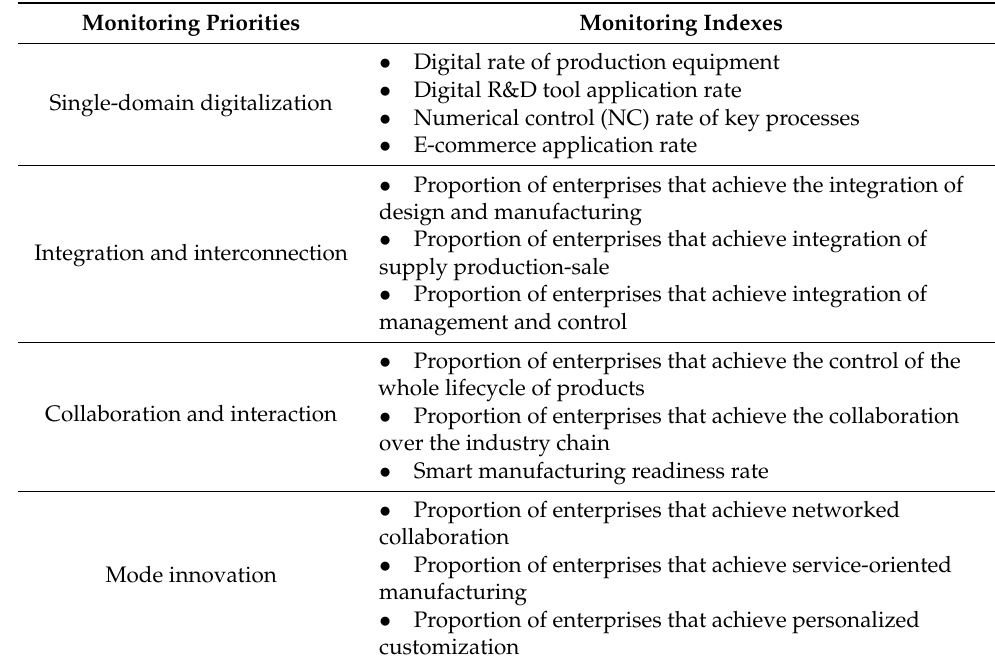
Table 1. Proposed Monitoring Index System for Sectors’